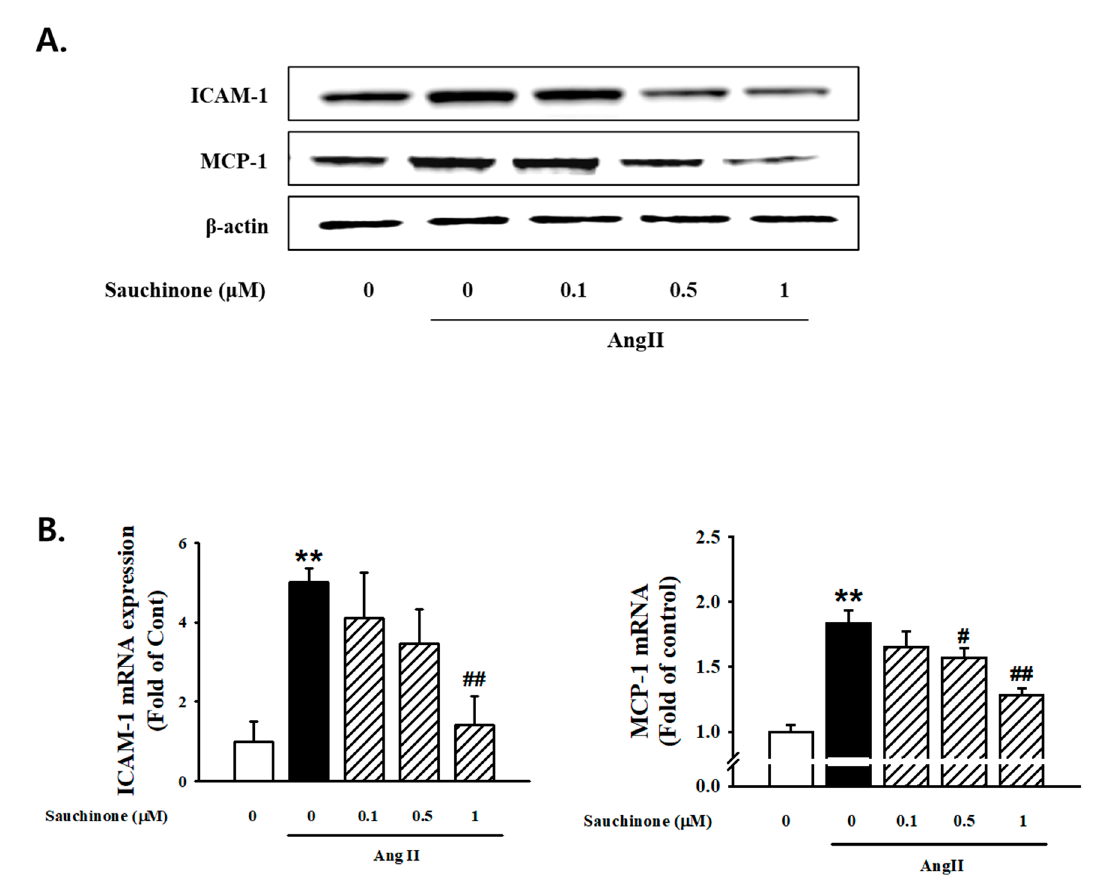
Figure 4. E ff ect of sauchinone on AngII-induced mesangial cell inflammation. ( A ) Western blotting and ( B ) real-time PCR showed protein and mRNA levels of intercellular adhesion molecule-1 (ICAM-1) and monocyte chemoattractant protein-1 (MCP-1) in sauchinone-treated and AngII-stimulated cells at 48 h. β -actin or GAPDH were used as the internal standard in each sample. ** p < 0.01 vs. control and ## p < 0.01, # p < 0.05 vs. AngII alone.